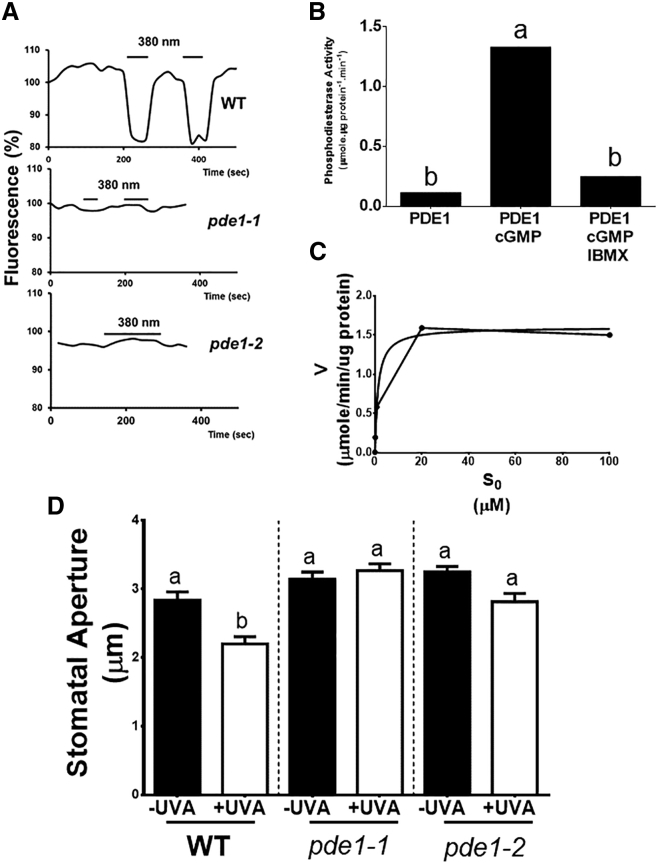
AtPDE1 Encodes a Phosphodiesterase Activated by cGMP and Inhibited by IBMX(A) Mesophyll protoplasts were extracted from WT, pde1-1 and pde1-2 leaves and transiently transformed with δ-FlincG. UVA illumination (10 μmol m−2 s−1 [λmax = 380 nm]) induced a significant reduction in δ-FlincG fluorescence in WT, but no significant decrease was observed in either pde1-1 or pde1-2 (representative plot out of 3 experiments).(B) cGMP activity of PDE1. PDE1 was expressed in vitro, and its cGMP activity was measured. PDE1 activity was stimulated by cGMP (50 μM) and inhibited by 50 μM IBMX. Data represent means. Statistical analyses were performed by one-way ANOVA with Tukey post hoc analysis. Letters show significant differences at p < 0.05.(C) Michaelis-Menten plot of the phoshopdiesterase activity of PDE1. Vmax and Km observed were 58.22 pmole min−1 μg protein−1 and 0.2587 μM, respectively.(D) pde1-1 and pde1-2 do not exhibit UVA-induced inhibition of blue- and red-light-induced stomatal opening. Isolated epidermes were incubated in buffer 10 mM MES/KOH, 50 mM KCl, pH 6.15 and illuminated with 10 μmol m−2 s−1 blue (λmax = 470 nm) and 50 μmol m−2 s−1 red (λmax = 660 nm) in the presence or absence of 10 μmol m−2 s−1 UVA (λmax = 380 nm). Stomatal apertures were measured after 3 h illumination. Data represent means (+/− SEM) of 90 stomatal aperture measurements from three replicates. Statistical analyses were performed by one-way ANOVA with Tukey post hoc analysis, and letters show significant differences at p < 0.05.See also Figures S1 and S3.